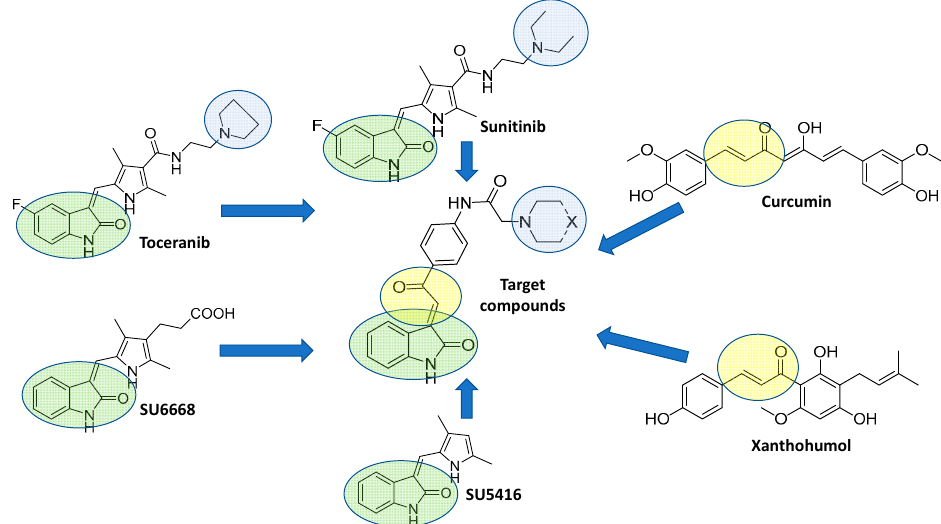
Figure 1. Rational design of the target compounds based on oxindole hybridization with α , β -unsaturated ketone.